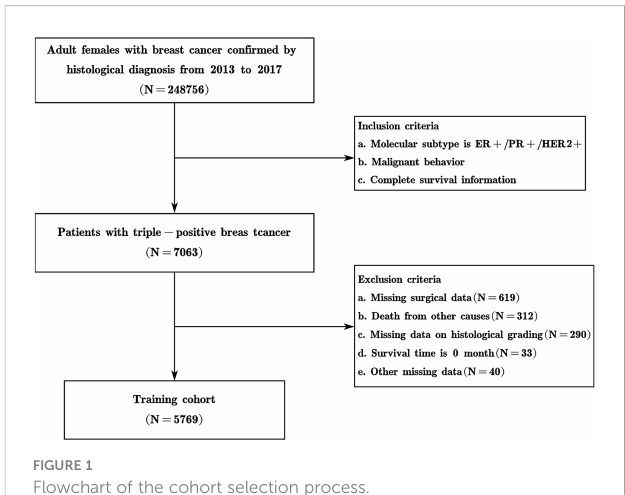
FIGURE 1 Flowchart of the cohort selection